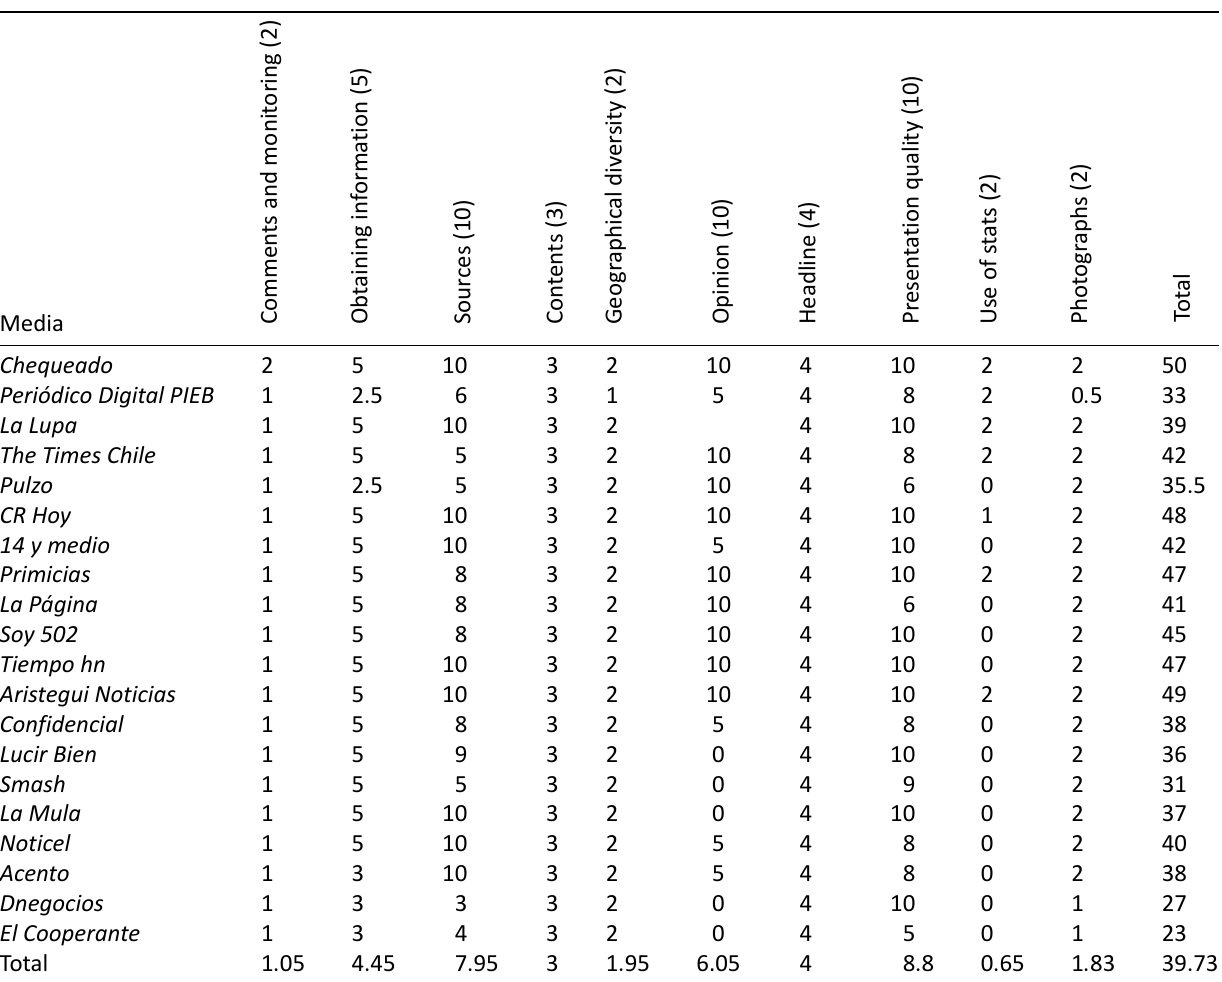
Table 5. Assessment of digital native media